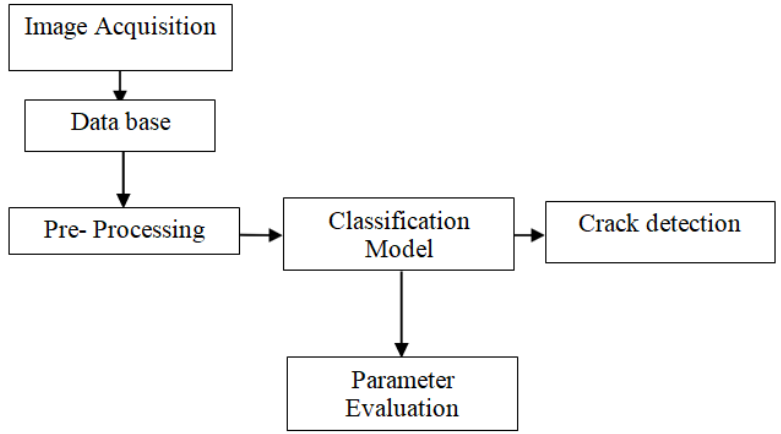
Figure 1. General block diagram for crack detection.